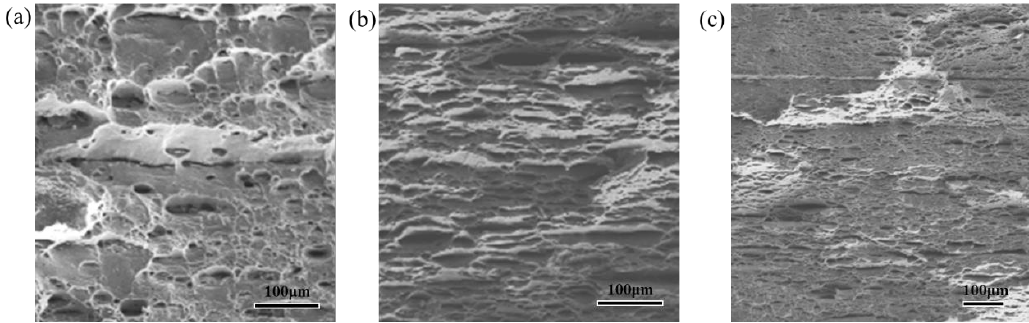
Figure 5. Tensile fracture morphologies of Al/CNTs nanocomposites with 0 ( a ), 0.5 ( b ) and 1.0 ( c ) vol.% CNTs after 12 ARB cycles.